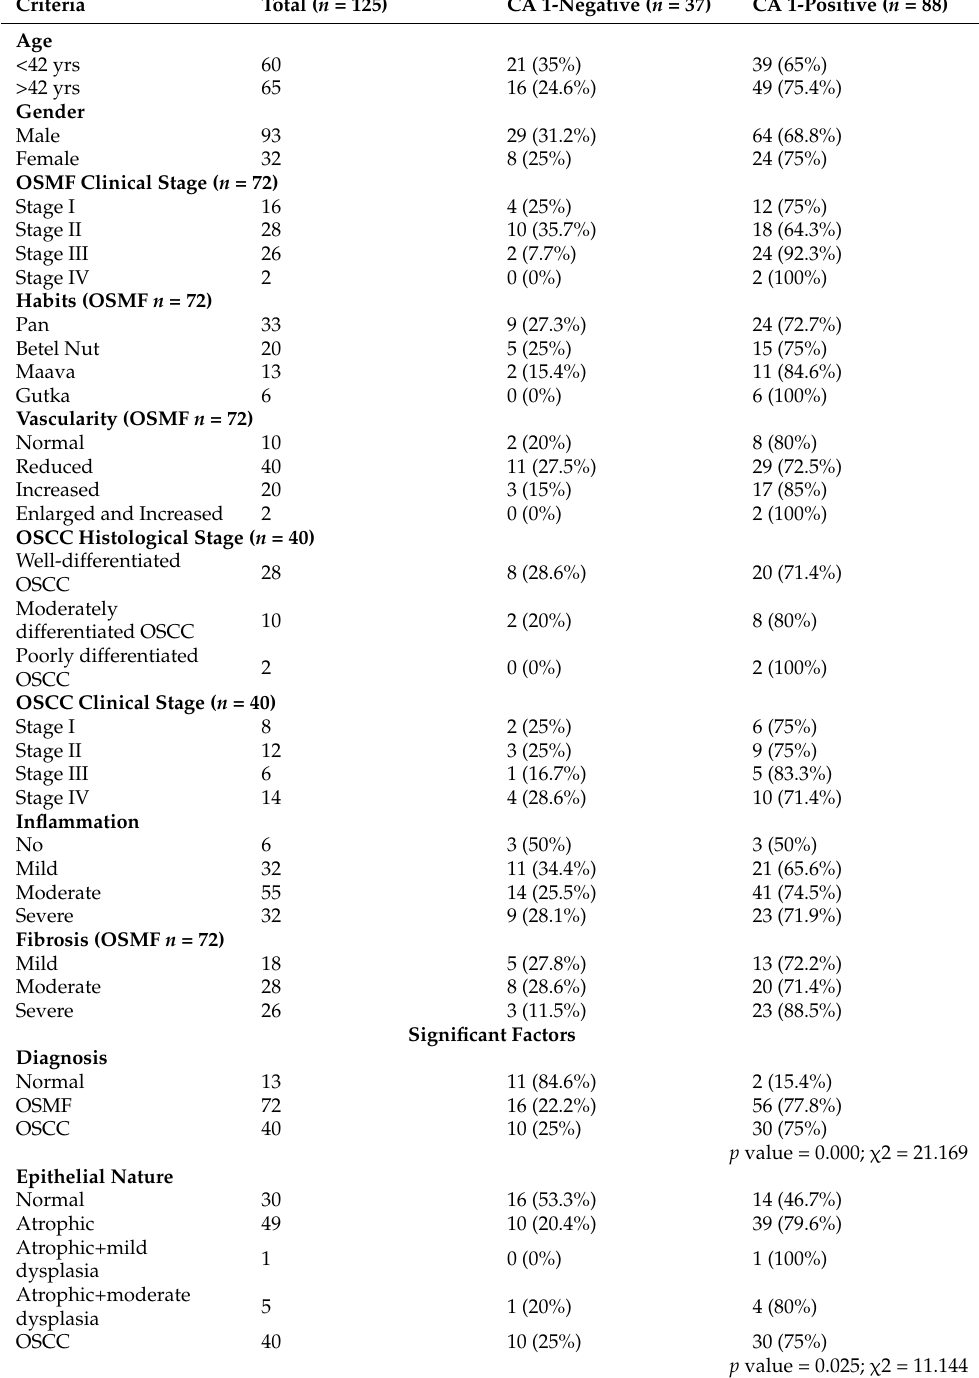
Table 3. Clinical histopathological features in CA 1-positive and -negative groups of OSMF, OSCC and normal